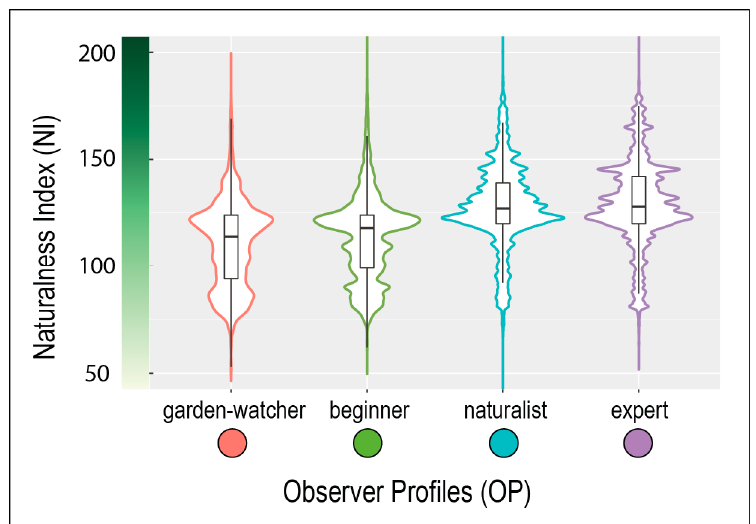
Figure 5. Shapes of violin represent the kernel density of the NI data records for the four OP (garden- watchers, beginners, naturalists, and experts). Boxplots with medians are given within violin plot.